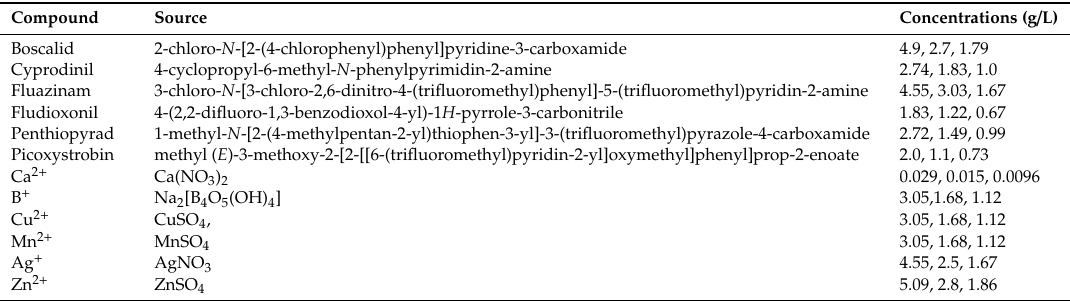
Table 3. Fungicides and metallic cations used in this